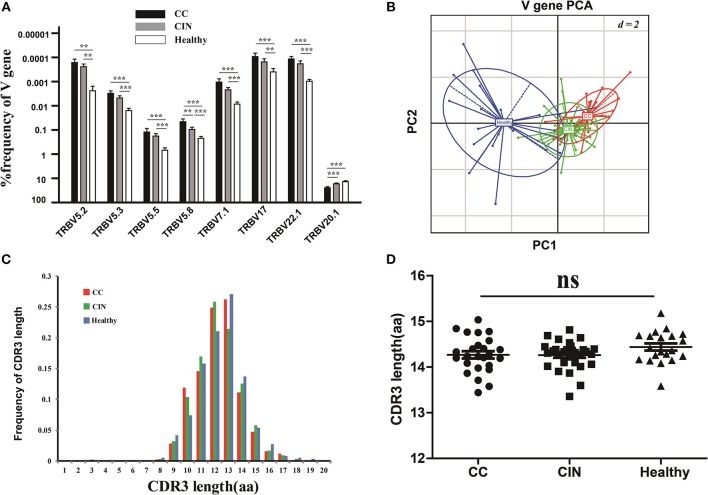
Comparisons of the TCRβ (TRB) V gene usages and the CDR3 length distributions in peripheral blood TCR repertoires among the CC, CIN and healthy groups. (A) The TRBV genes with usage differences among the CC, CIN, and Healthy groups. Bars depict the mean (±SEM) of each group. **P < 0.01, ***P < 0.001, one-way ANOVA test. (B) Principal component analysis of the TRBV genes with usage differences. PC1 refers to the first principal component, whereas PC2 indicates the second principal component. (C) The distribution of CDR3 lengths in the CC, CIN and healthy groups. (D) The CDR3 average length in the CC, CIN, and healthy groups. ns, no significant difference, one-way ANOVA test.